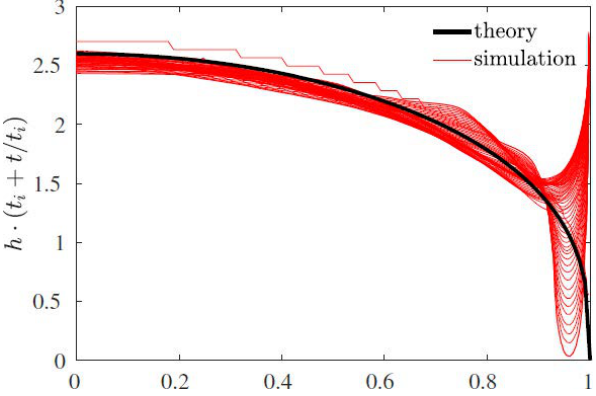
Fig. 1 Output divergence of CFE-Euler simulation